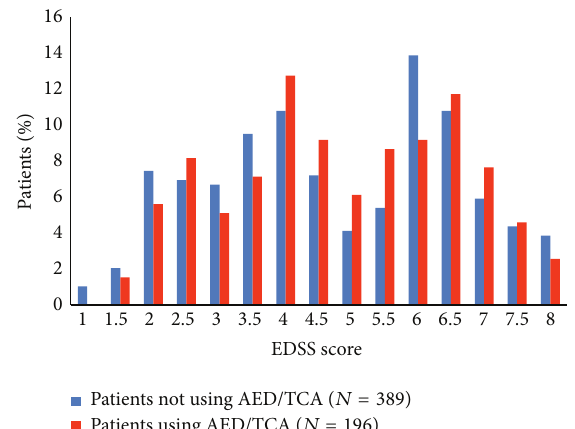
Figure 2: Expanded Disability Status Scale score distribution of the MS Rehabilitation Centre population ( 𝑁 = 585 ) divided into two groups based on the use of antiepileptic drugs (AED) and/or amitriptyline